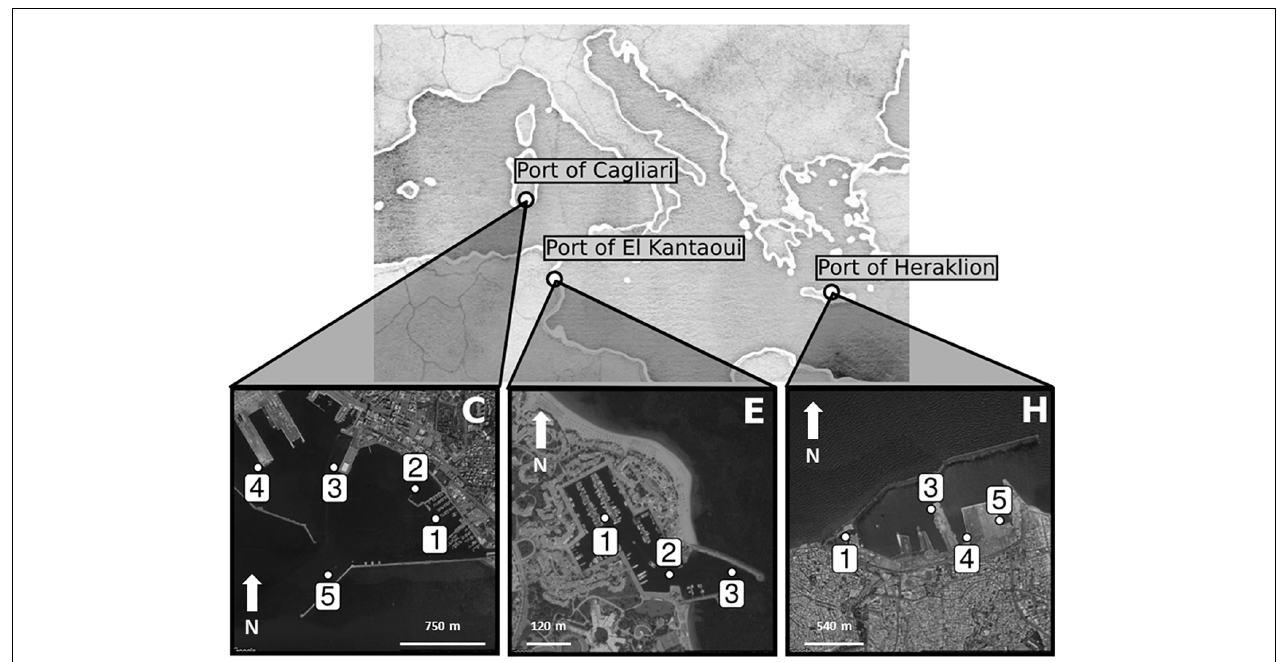
FIGURE 1 | Maps of the touristic ports of Cagliari (C), El Kantaoui (E), Heraklion (H). The position of the sampling stations is indicated on the maps.